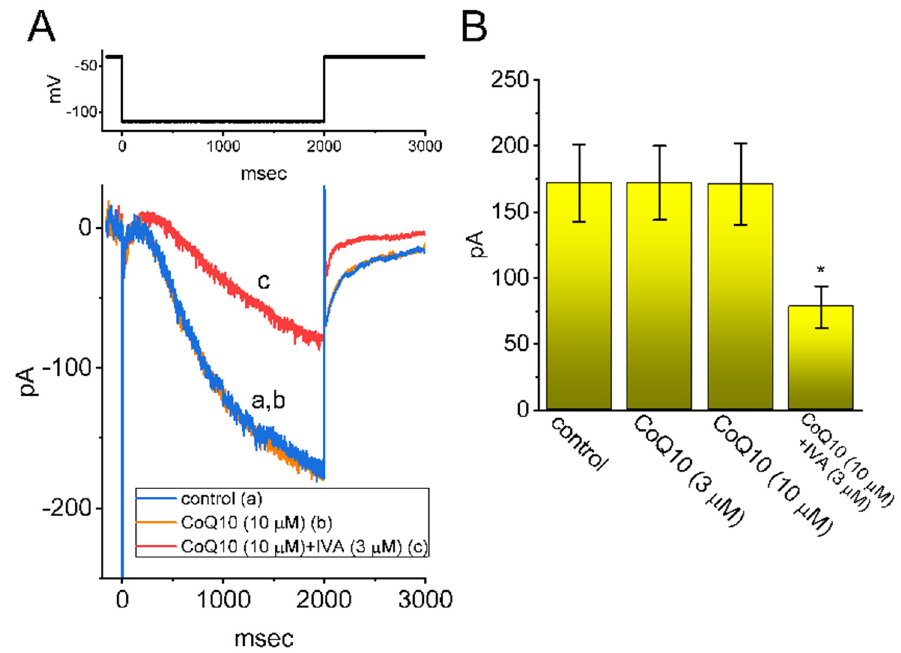
Figure 5. Effects of ubiquinone (CoQ10) on the hyperpolarization-activated cation current ( I h ) in GH 3 cells. The introduction of CoQ10 was ineffective at perturbing the amplitude and gating of the hyperpolarization-activated cation current ( I h ) in GH 3 cells. This set of experiments was conducted in cells which were bathed in Ca 2+ -free Tyrode’s solution containing 1 µ M of TTX, and the pipette was filled with a K + -containing solution. ( A ) Representative current traces obtained (a) during the control period and during cell exposure (b) to 10 µ M of CoQ10 and (c) to 10 µ M of CoQ10 plus 3 µ M of IVA. The voltage-clamp protocol applied is illustrated in the upper part. ( B ) A summary bar graph showing the effects of CoQW10 and CoQ10 plus IVA on the amplitude of the I h (mean ± SEM; n = 8, for each bar). The current amplitude was measured at the endpoint of the hyperpolarizing step pulse from − 40 to − 110 mV for a duration of 2 s. * Significantly different from the control group ( p <